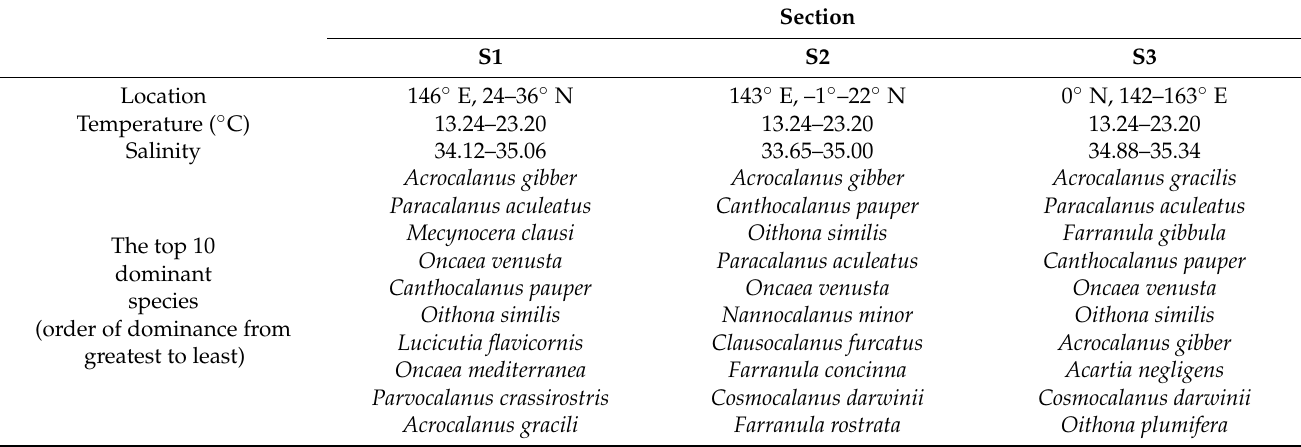
Table 1. Temperature, salinity, and dominant species in the S1, S2, and S3 cross-sections.